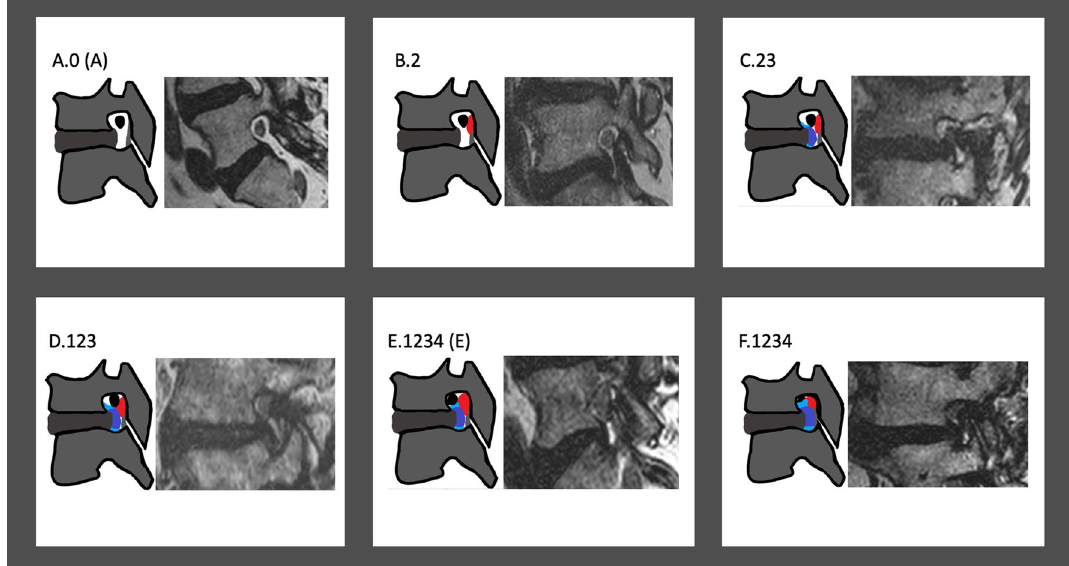
Figure 2. Schematic illustrations and imaging examples of relevant cases described in the updated grading system. The color red signifies the ligamentum flavum; the color dark blue signifies the posterior disc protrusion and the color light blue signifies the adjacent